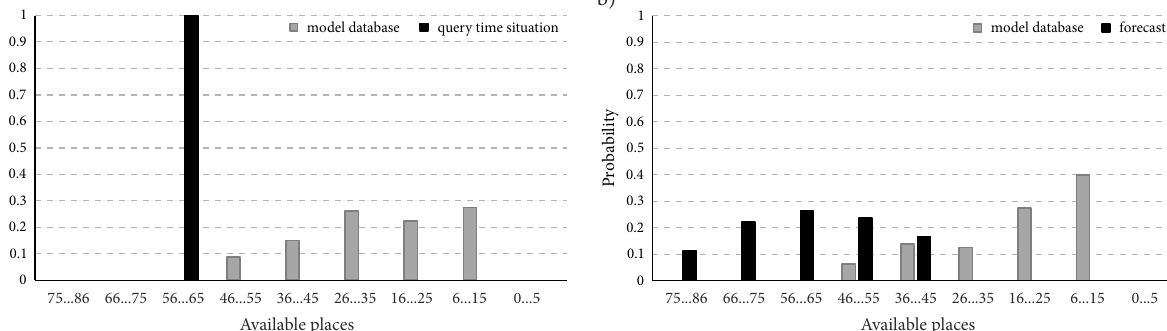
Figure 6. Graphical presentation of the received results for non-standard situation: a – situation at query time; b – forecast for arrival